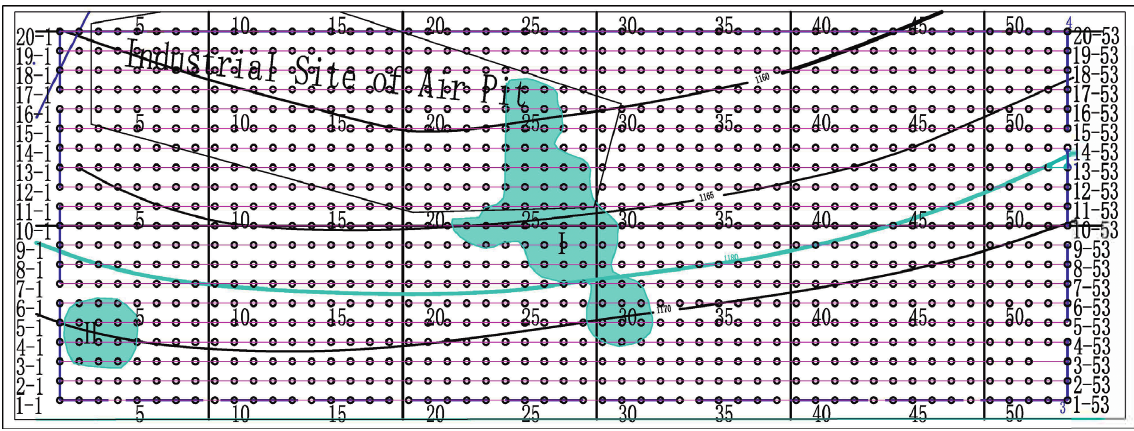
Figure 18: Geophysical exploration